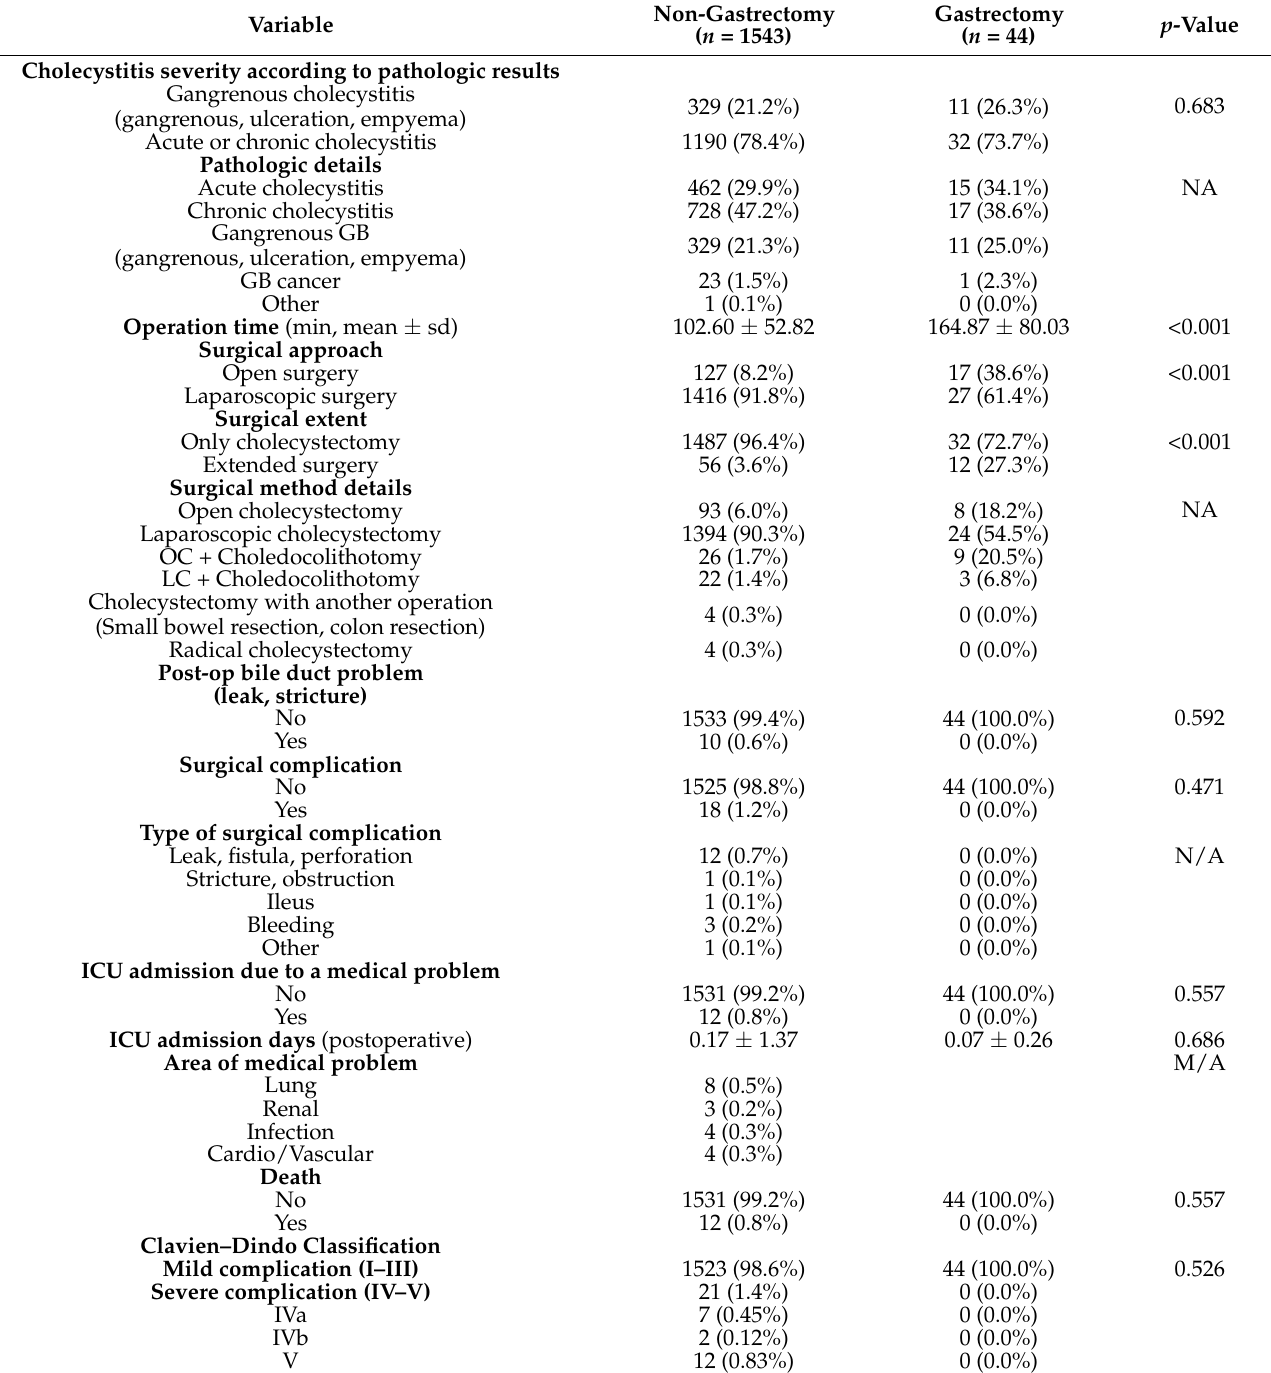
Table 2. Pathologic and surgical characteristics of cholecystectomy